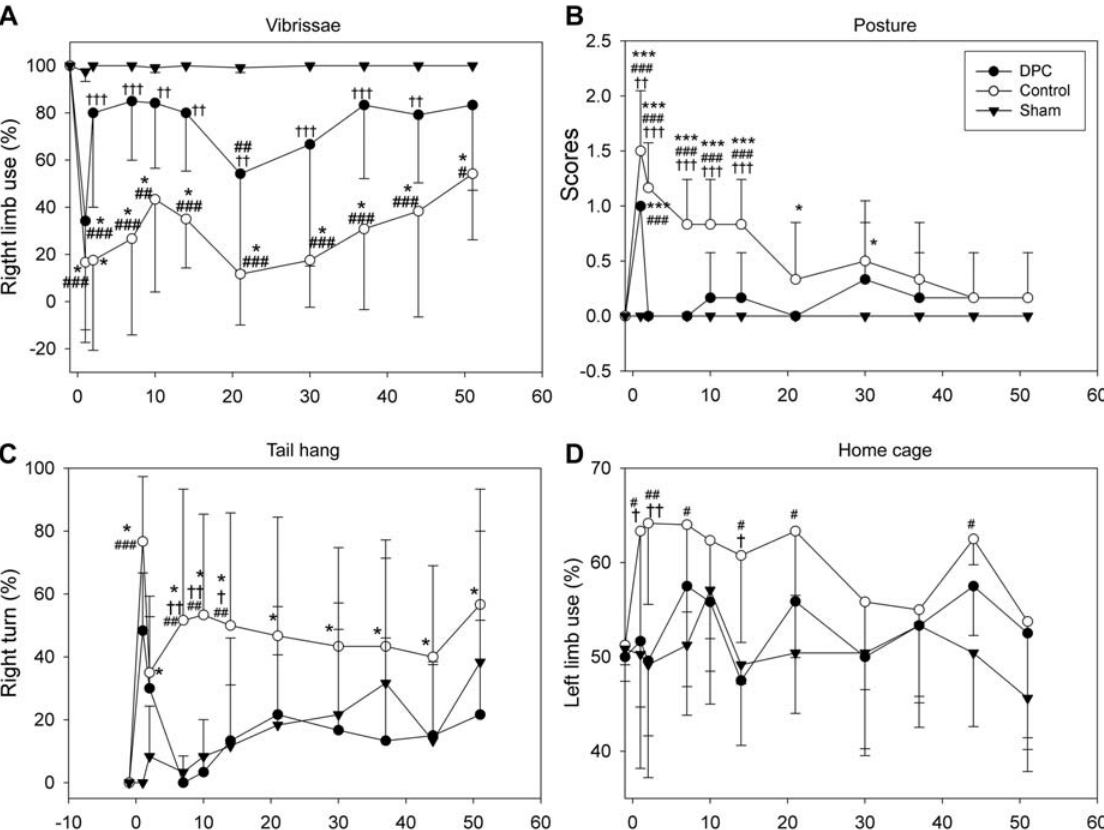
Figure 5. Delayed postconditioning attenuated behavioral deficits up to 2 months post-ischemia. Delayed postconditioning (DPC) was conducted with 6 cycles of 15 min occlusion/15 min release in the ipsilateral CCA occlusion 6 h after stroke. Four tests were performed: A. Vibrissae-elicited forelimb placement test. All sham rats showed normal forelimb placing. There was unsuccessful placing of the contralateral forelimb after stroke in control rats; postconditioning attenuated the overall deficit from 1 to 51 d after stroke. The analysis of Two-way repeated measures ANOVA show that there are significant differences between groups: sham vs DPC, P=0.037; sham vs control ischemia, P , 0.001; DPC vs control ischemia, P=0.003. * vs. before ischemia, P , 0.5; # , ## , ### vs. sham, P , 0.05, 0.01, 0.001; {{ , {{{ , vs. postconditioning, P , 0.01, 0.001. N=6/each group. B. Postural reflex test. Scores significantly increased in control rats at 1, 2, 7, 10, and 21 d after stroke; postconditioning reduced scores at 1, 2, 7, 10 d after stroke. Two-way repeated measures ANOVA shows that there are significant differences between groups: sham vs DPC, P=0.058; sham vs control ischemia, P , 0.001; DPC vs control ischemia, P , 0.001.. *, *** vs. before ischemia, P , 0.01, 0.001. ### vs. sham, P , 0.001; {{ , {{{ vs. postcon, P , 0.01, 0.001; . C.Tail hang test . The number of large right turns induced by tail hanging increased in control rats; postconditioning blocked right turns at 7, 10, and 14 d. Two-way repeated measures ANOVA: Control vs sham, P=0.022; control vs DPC, P=0.014; DPC vs sham, P=0.805. *, vs. before ischemia, P , 0.05; ## , ### , vs. sham, P , 0.01, 0.001; { , {{ , vs. postconditioning, P , 0.05, 0.01. D. Home cage forelimb use test. Left-limb-use increased at 1, 2, 7, 10, 14, 21 and 44 d, which was blocked by postconditioning. Two-way repeated measures ANOVA: control ischemia vs sham, P=0.004; control ischemia vs DPC, P=0.010; DPC vs sham, P=0.375. # , ## vs. sham, P , 0.05, 0.001; { , {{ , vs. postcon, P , 0.05, 0.001; ** vs. before ischemia.